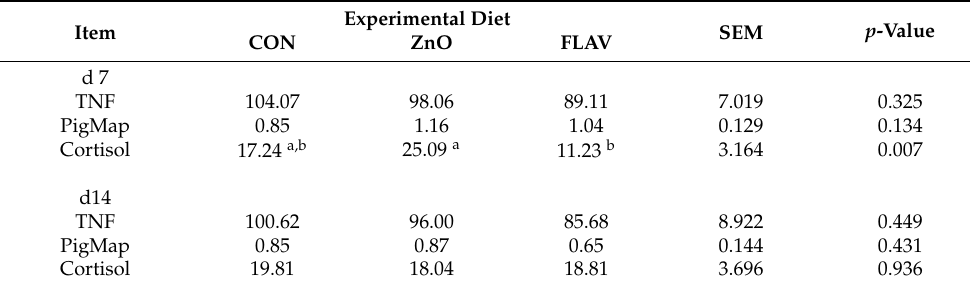
Table 7. Effect of experimental diets on proinflammatory and stress biomarkers of weaned pigs 1